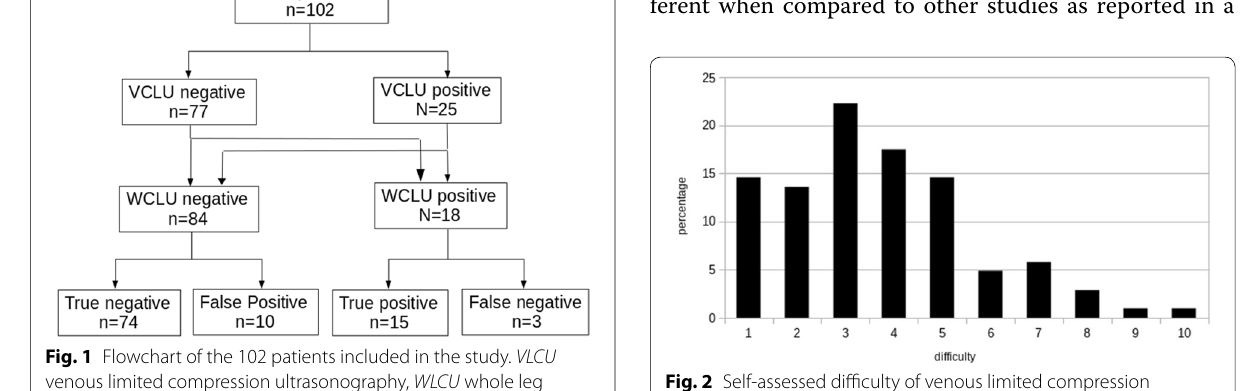
Fig. 2 Self-assessed difficulty of venous limited compression ultrasonography performed by 46 residents on 102